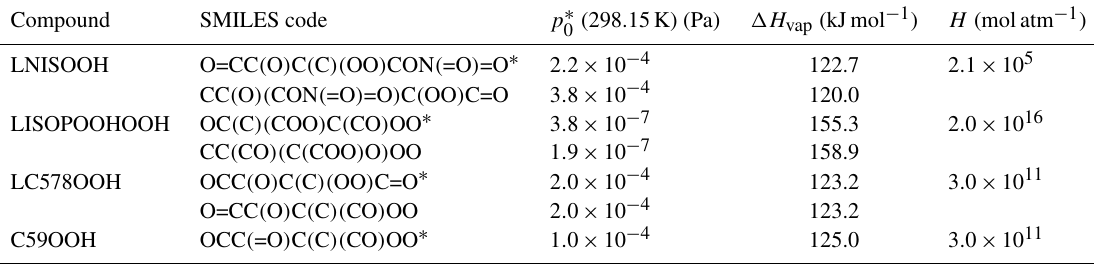
Table 1. Isoprene oxidation products in JAM3, physical characteristics and molecular structure expressed as SMILES code. Pure-liquid saturation vapor pressure at the reference temperature 298K p ∗ , Henry’s law coefficient H and evaporation enthalpy (cid:49)H vap . (cid:49)H vap and 0 p ∗ are used in the Clausius–Clapeyron equation for the calculation of the effective saturation vapor pressure as a function of temperature in 0 SALSA. The names of the compounds rely on the Master Chemical Mechanism (MCM 3.2), except for LISOPOOHOOH, which is not in MCM